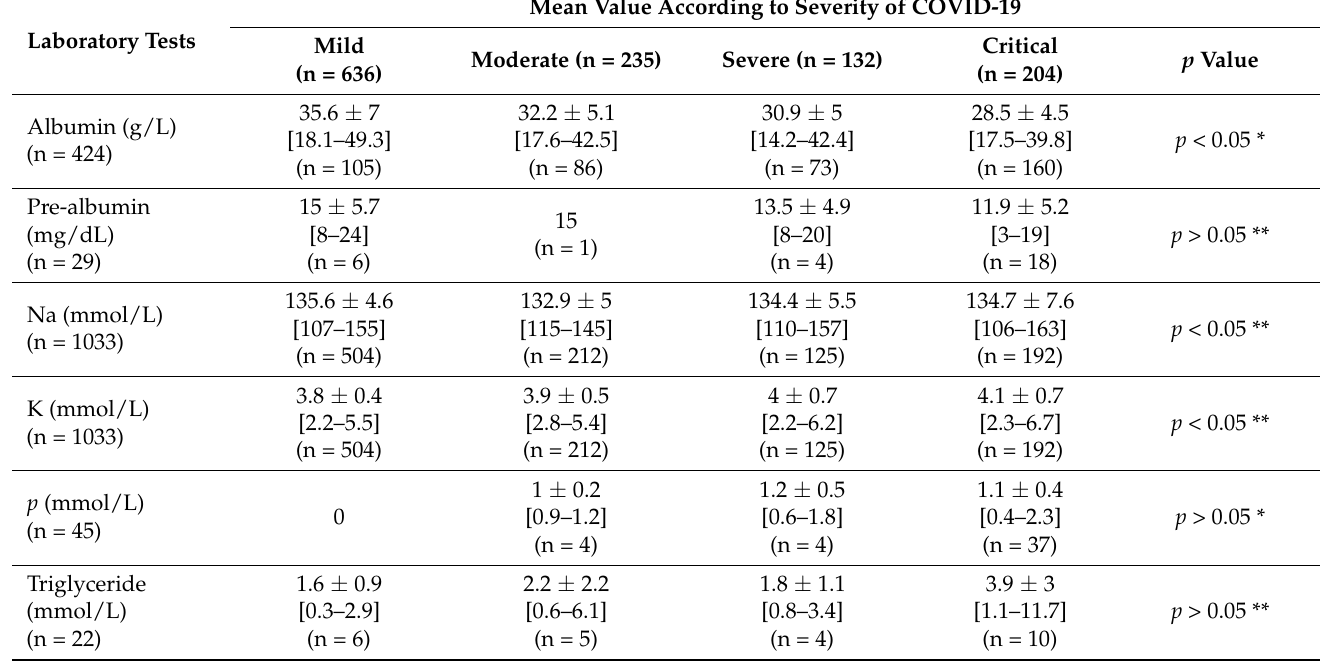
Table 2. Values of laboratory tests classified by severity of COVID-19.